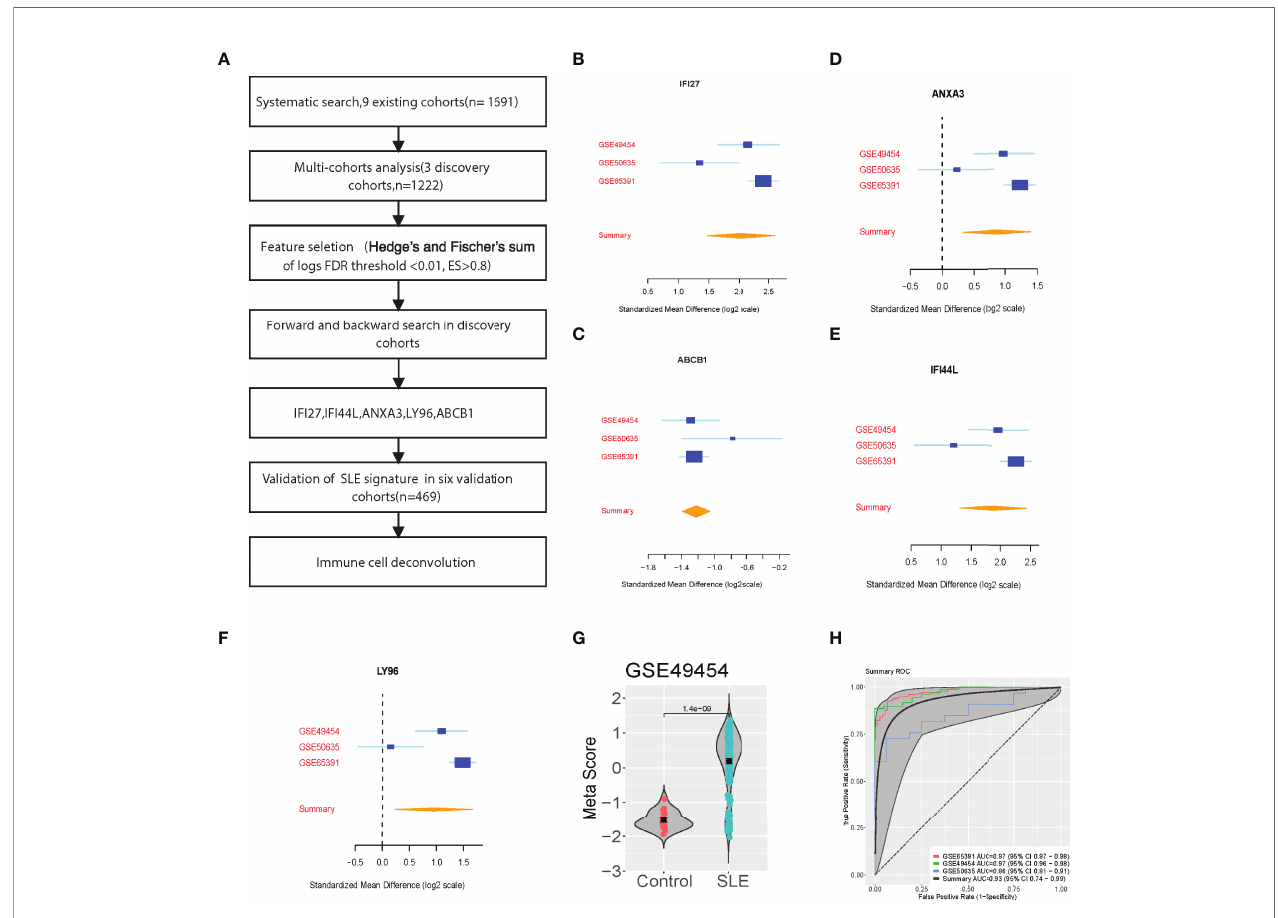
FIGURE 1 | Discovery of the fi ve-Gene signature diagnosis of SLE. (A) Multi-cohort analysis work fl ow for identifying and validating the 5-gene signature. (B – F) 5-gene signature from the forward search. (G) A representative violin plot illustrating the performance of the 5-gene signature to differentiate SLE from Control in one of the discovery cohorts (GSE49454, Supplementary Figure S1 ). (H) ROC curves of patients with SLE versus controls in three discovery